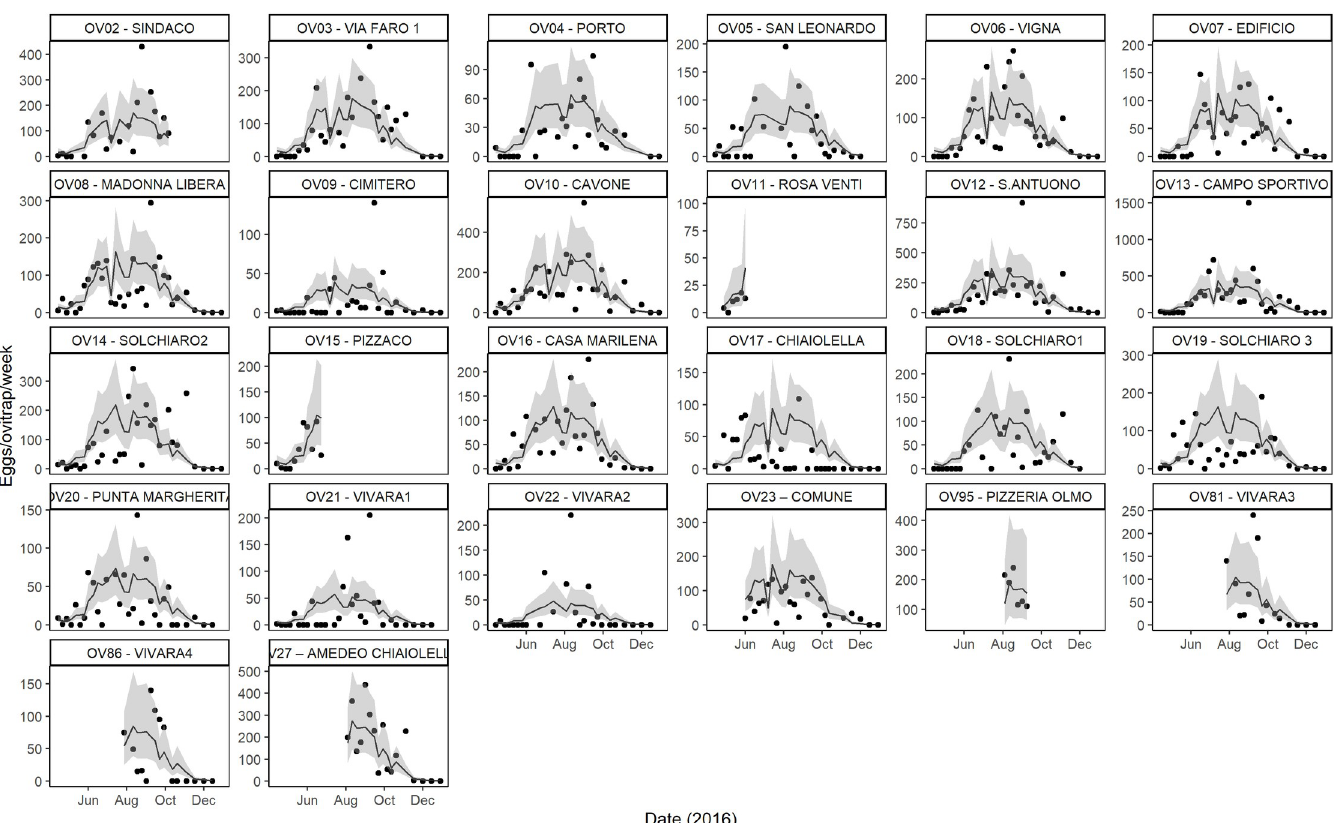
Fig 2. Observed and expected values Ae . albopictus eggs/ovitrap/week on Procida Island in 2016 estimated by GAMM model. Each panel represents a single ovitrap. Black dots = observed values of eggs/ovitrap/week; solid line = GAMM posterior mean value of eggs/ovitrap/week; grey area = 95% credible interval; x-axis = months of collections in 2016; y-axis = eggs/ovitrap/week; the scale differs per panel to help